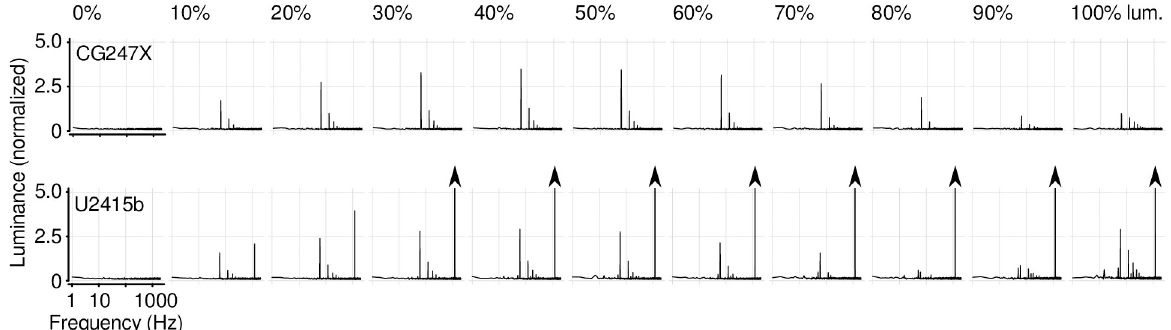
Fig 4. Temporal uniformity of nominally static test patches. We presented nominally static test patches at display position 5 (Fig 2, inset), measuring luminance with a linearized photodiode device. At each luminance (0, 10, 20 ... 100%) we made ten 1-second recordings, deriving the Fourier amplitude spectrum for each. Each spectrum illustrated is the average of 10 spectra. For each display, we normalized spectra such that 1000 corresponds to the DC component at 50% luminance; therefore, a value of 5.0 corresponds to approximately 0.15 cd/m 2 . The spectra of the CG247X (upper) revealed a frame response, comprising a 60 Hz component and harmonic components at integer multiples of 60 Hz. This frame response varied non-monotonically in amplitude with the luminance of the static test patch, peaking between 40 and 50% luminance. The spectra of the U2415b (lower) also revealed a frame response, as well as 1.2 kHz flicker, the amplitude of which increased linearly with the luminance of the static test patch (amplitudes above 5.0 are not shown, arrowheads). For the U2415b, mains noise (50 Hz) was apparent at high-luminance. lum.,